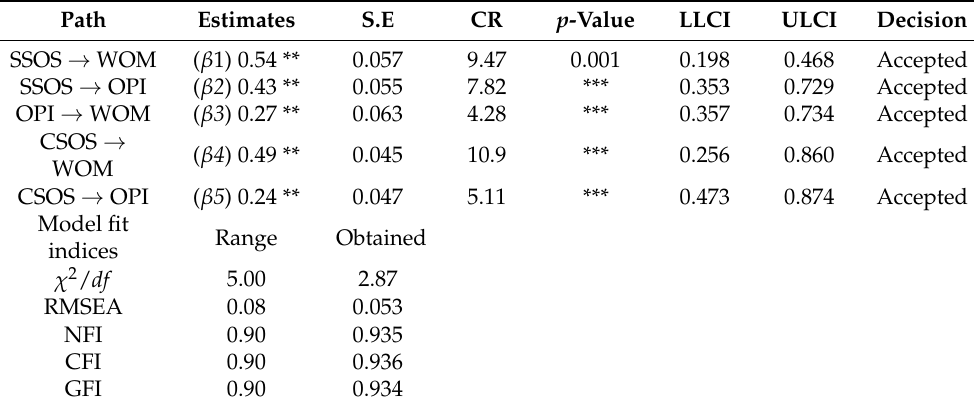
Table 4. The results for hypotheses 1, 2, 3, 4, and